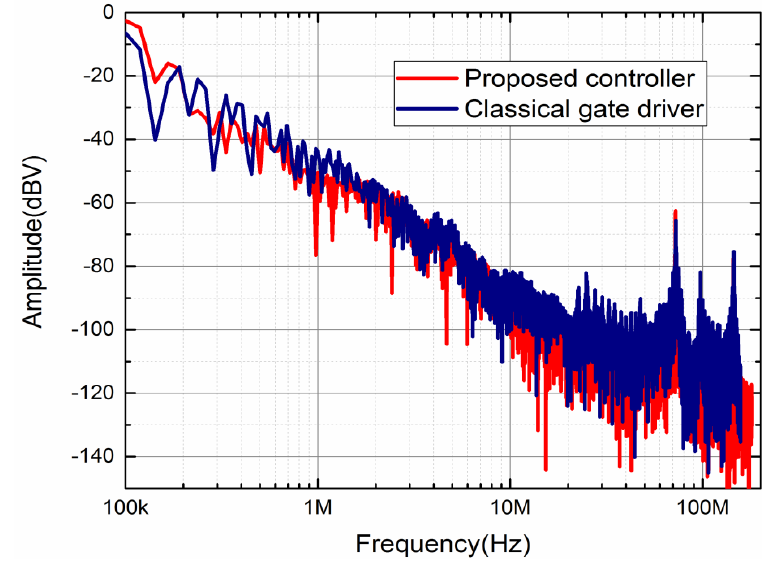
Figure 13. Pspice simulation V ds spectra comparison (t off = t fall = 1.0 µs, purple: classic gate driver, red: